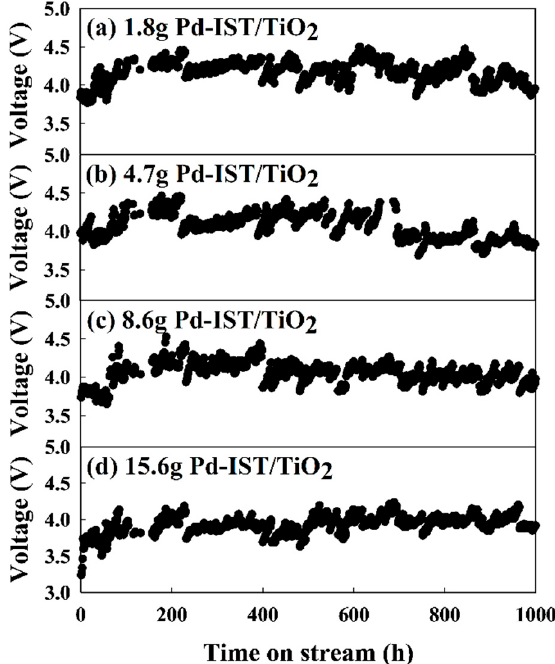
Table 4. The results of accelerated life test. Anode